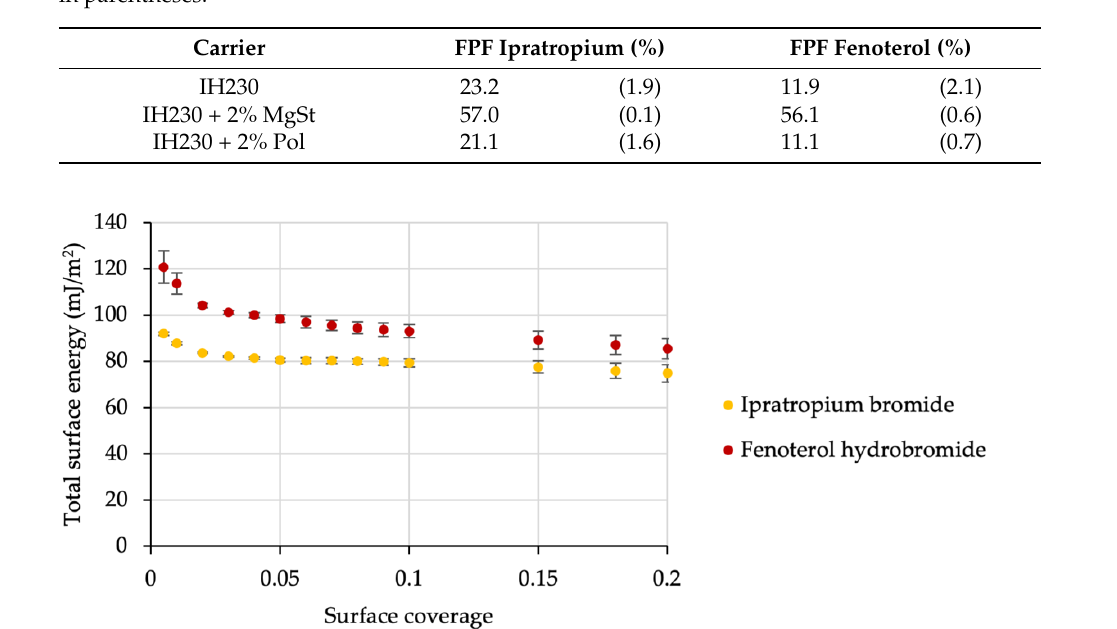
Table 1. Calculated FPFs at a 5 µ m cut-off, derived from NGI assessments. n = 3, standard deviation in parentheses.